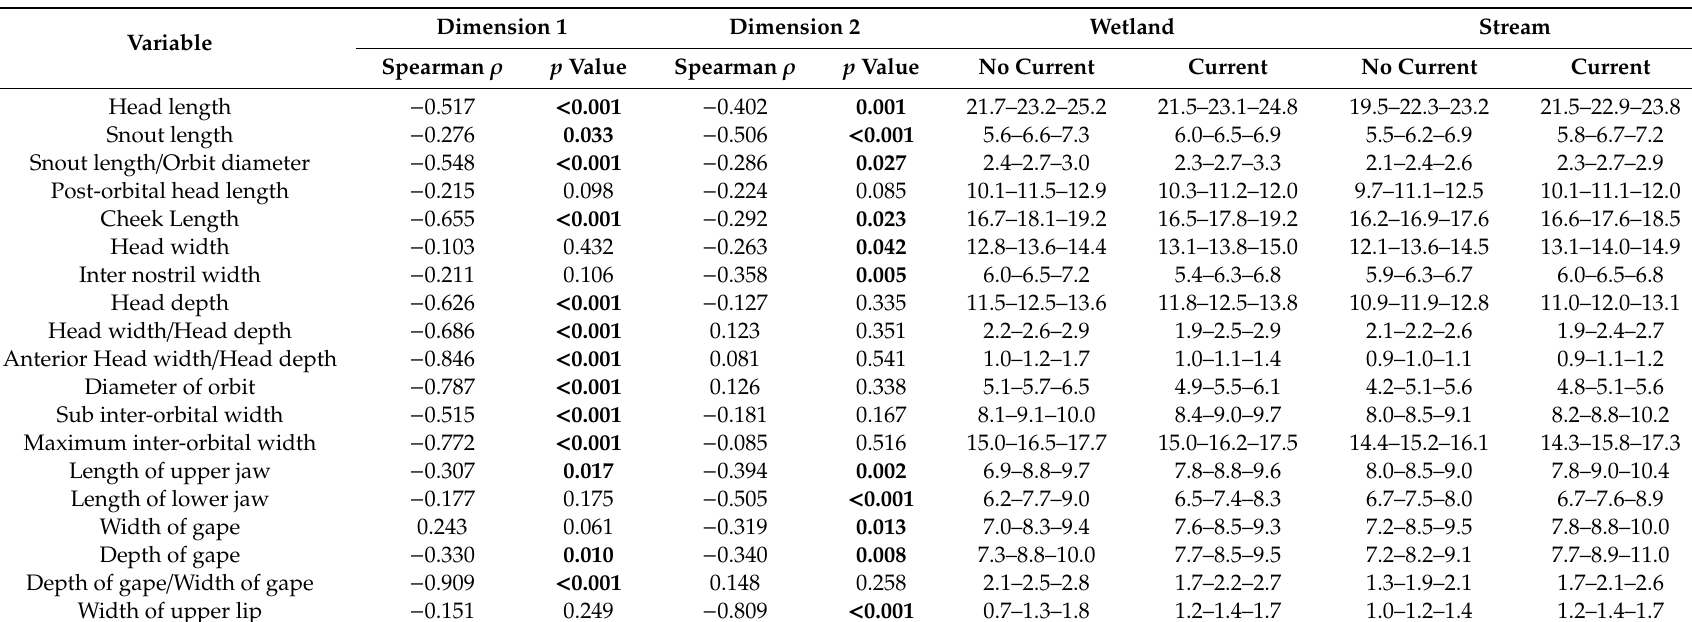
Table 2. Spearman ρ correlations of mean relativised standard length standardised morphological variables with the captive G. gollumoides head MDS dimension 1 and 2 scores, and untransformed minimum—mean—maximum percentages of standard length standardised variables within each experimental treatment. Bold text—significant at p <